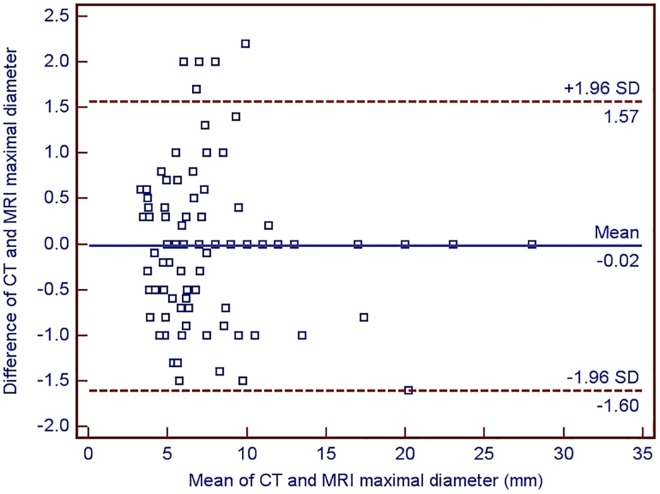
The Bland-Altman plot showing the agreement between the maximum diameter of 91 pulmonary nodules measured by both CT and MRI.